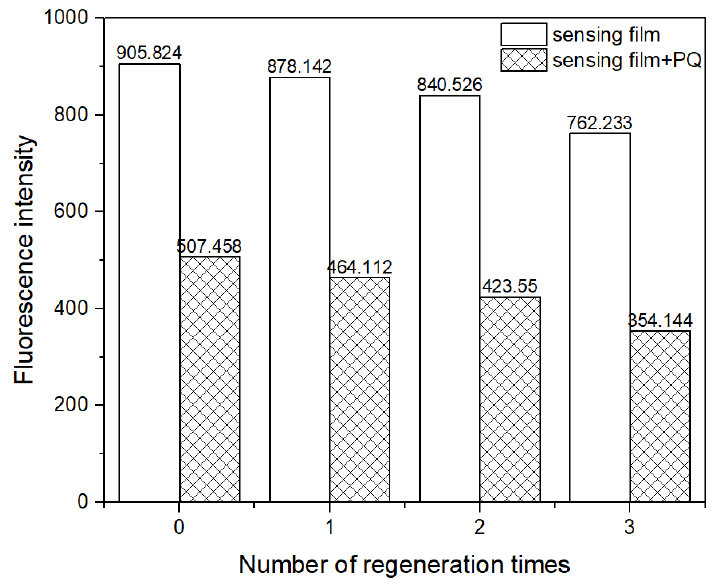
Figure 11. Regeneration of the sensing film.